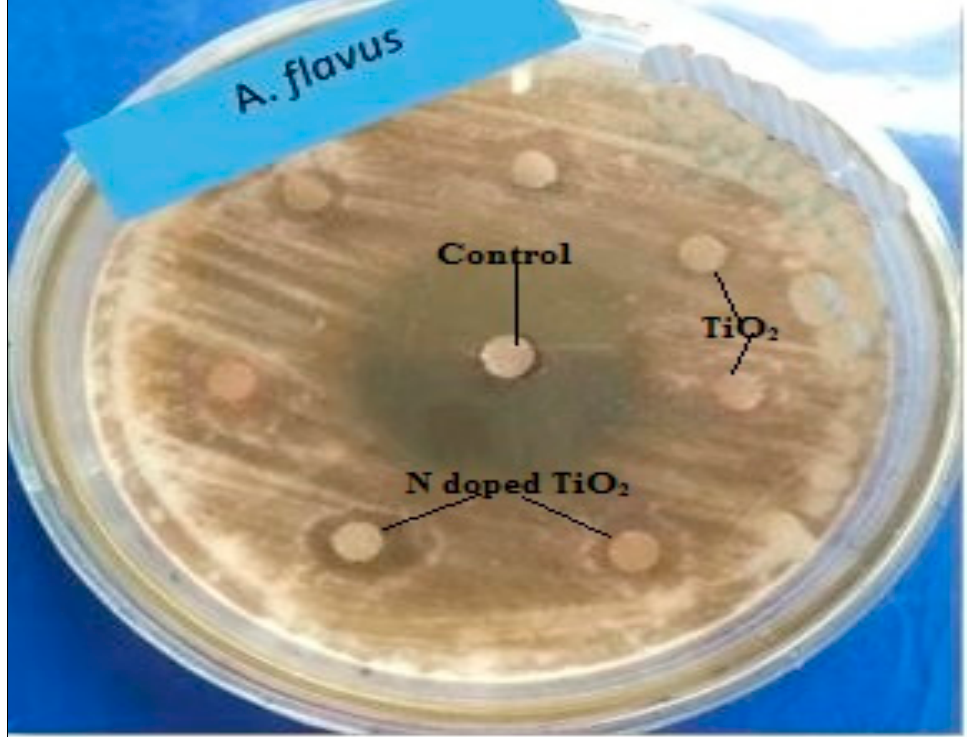
Figure 9. Antifungal activity: Zone of inhibition obtained against fungal strain, Aspergillus flavus by control, TiO 2 nanoparticles and N-doped TiO 2 nanoparticles.